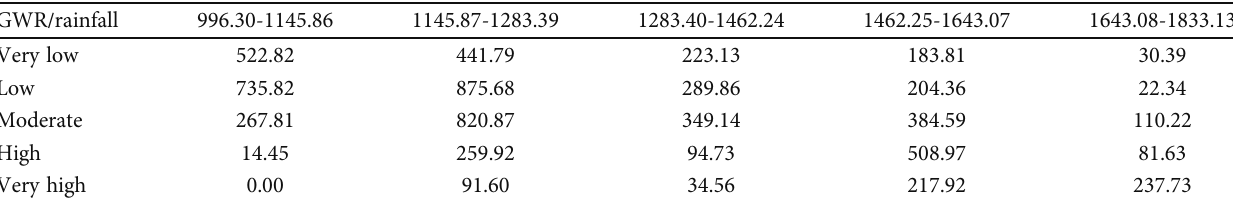
Table 12: Cross-tabulation between GWR and rainfall.